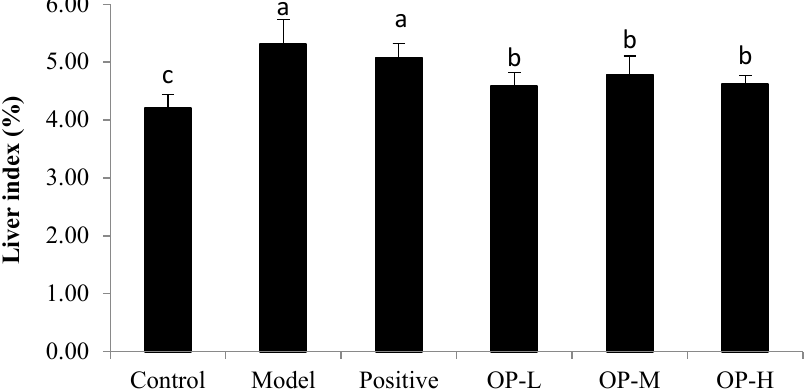
Figure 5. Effects of OP on the liver index of ALD mice (means ± SD, n = 10). Bars with different superscripts (a, b, and c) were significantly different ( p < 0.05) according to variance analysis (ANOVA) using the SPSS software (IBM SPSS Statistics 22, IBMCorp., Armonk, NY, USA) and means were compared by Duncan’s multiple comparison post-test.